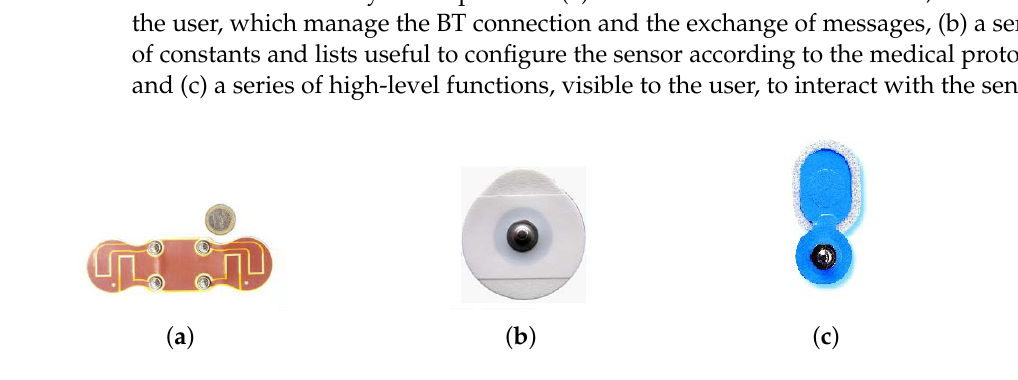
Figure 3. Types of electrodes: ( a ) patch supplied with the sensor (180 × 45 mm); ( b ) traditional electrodes (32 × 36 mm); ( c ) paediatric electrodes (34 × 40.8